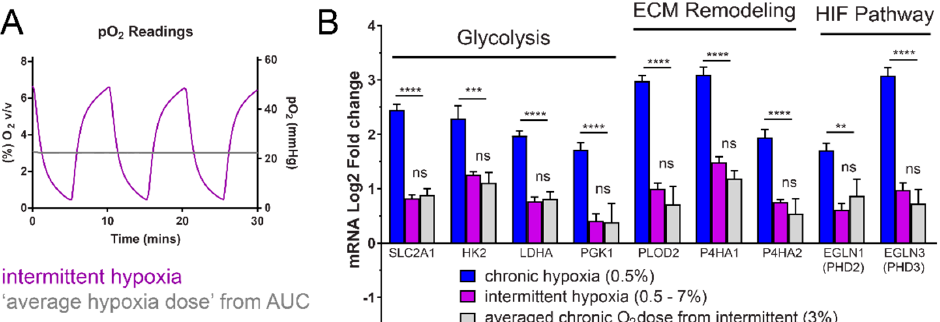
Figure 5. Hypoxia dose-dependent effect of intermittent hypoxia. ( A ) The area under the intermittent hypoxia curve (purple) was calculated using the measured pericellular oxygen values, to determine the ‘average’ dose of hypoxia (grey). ( B ) The equivalent chronic hypoxia dose at 3% leads to the same increase in HIF-target gene expression. The expression data from Figure 2B was compared to expression under 3% hypoxia conditions. 3% oxygen is the ‘averaged hypoxic dose’ equivalent to the same amount of oxygen given in one full cycle of intermittent hypoxia, but administered as a constant dose. The average hypoxia dose was calculated using the area under the curve from oxygen measurements in ( A ). Horizontal bars indicate comparison between chronic hypoxia (0.5%) and averaged intermittent hypoxia dose (3%). Results are the mean ± SEM of independent experiments run in duplicate ( n ≥ 3). ** p < 0.01, ns = not significant, *** p < 0.001 and **** p < 0.0001.